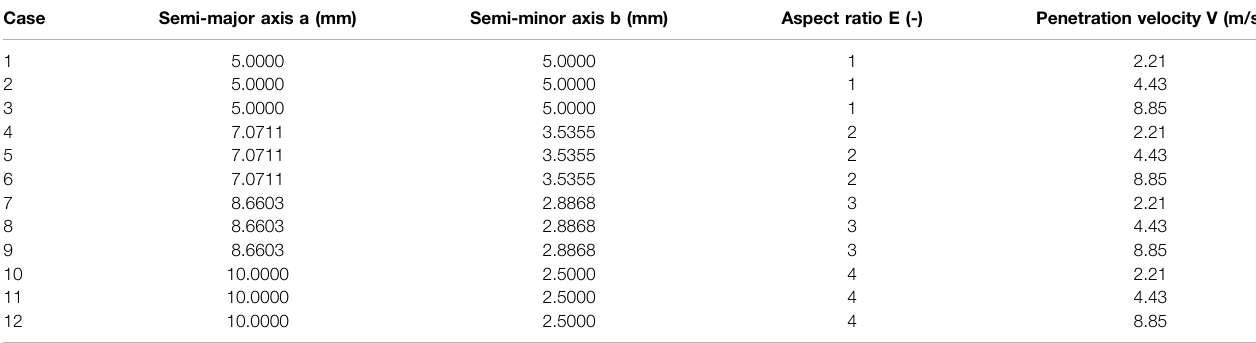
TABLE 1 | Parameters of the corium jets with four elliptical cross-sections and three velocities.